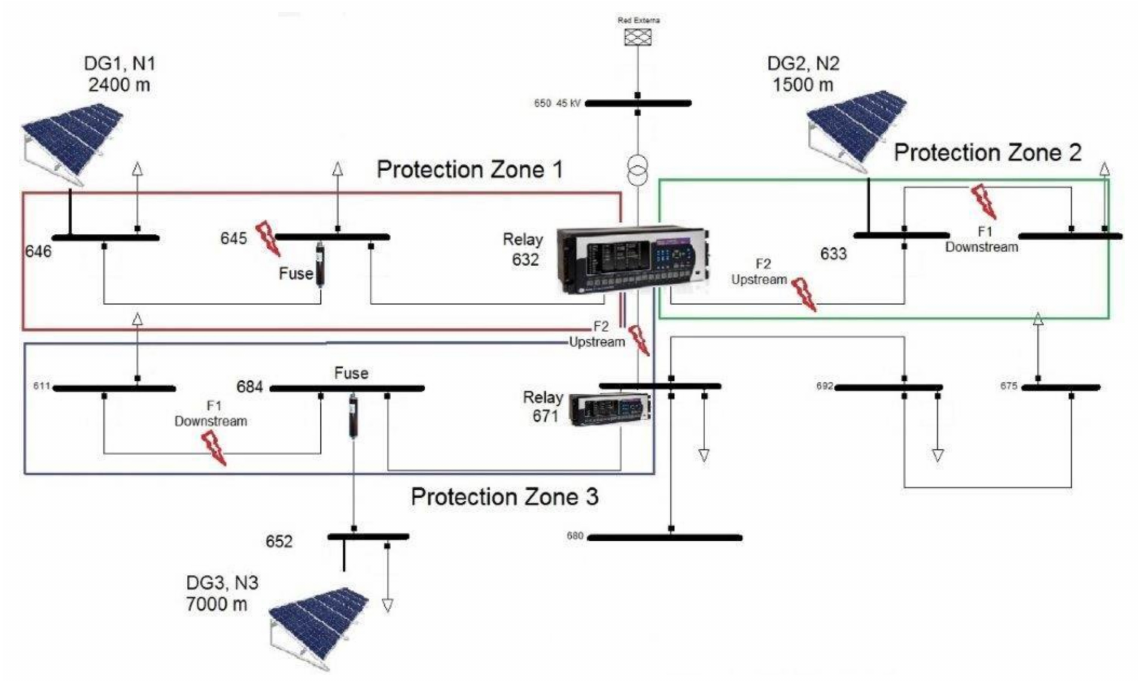
Figure 2. Example of the rural network topology studied in the present work. The position of the three DG included in the topology, N1, N2, and N3 (case studies), is indicated. The different protection zones are also indicated in the figure, together with the simulated